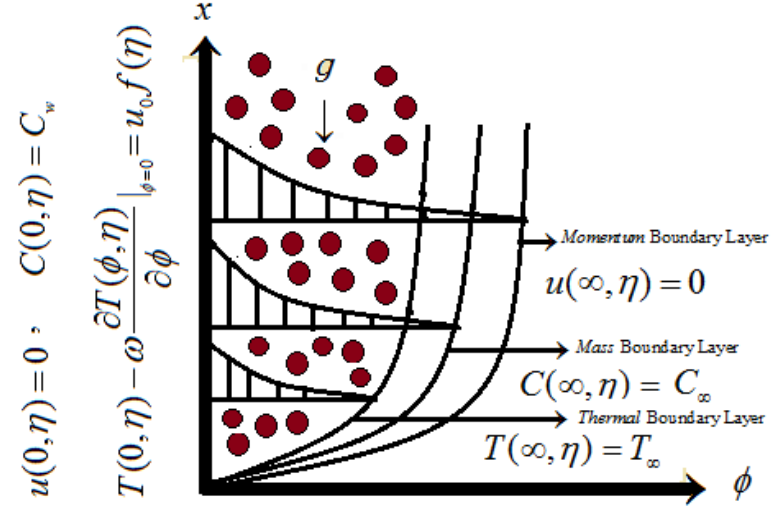
Figure 1. Geometrical formation of the flow